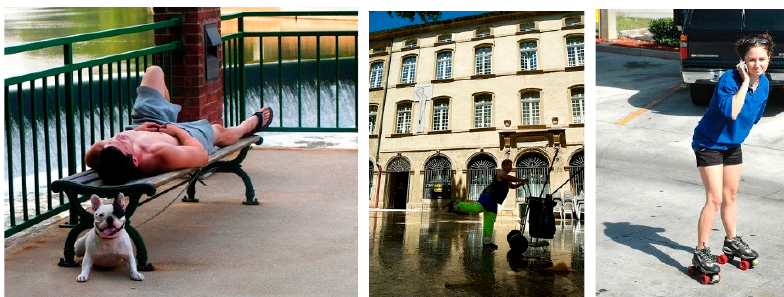
Figure 2. Images from the Flickr Image dataset [45]. The “leg” images set consisted of different kind of legs: male and female; with or without scars, hair, tattoos; etc.